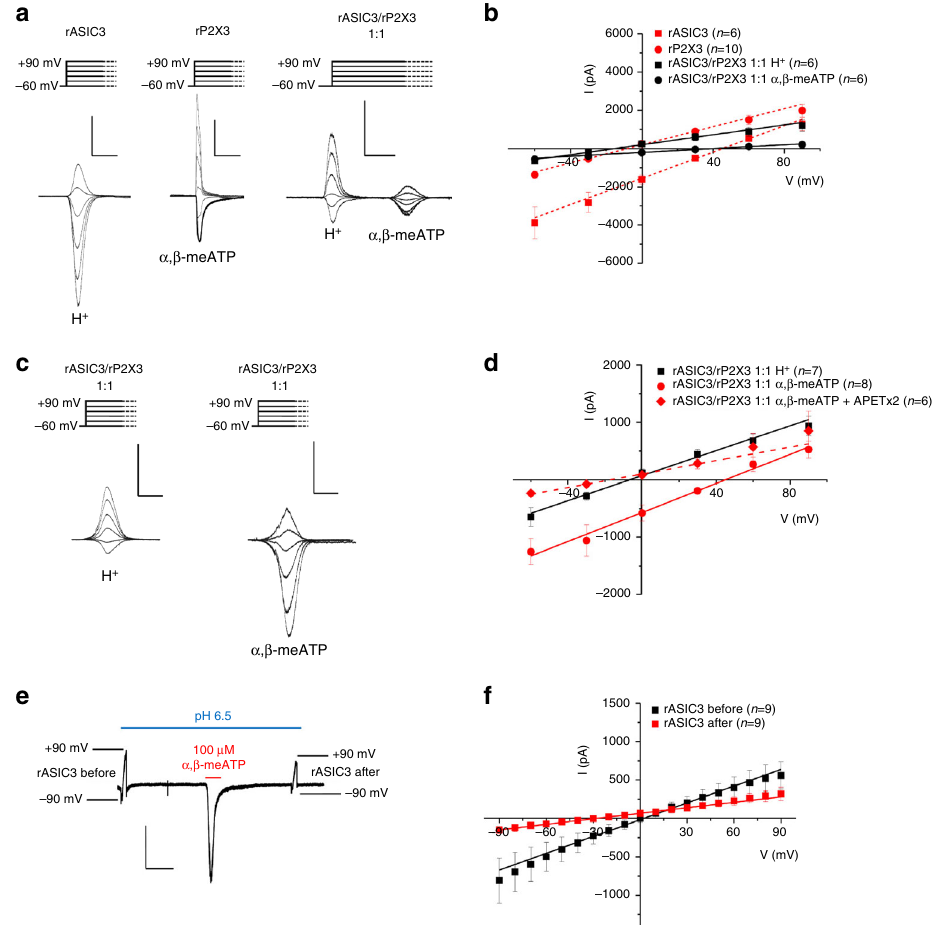
Fig. 5 Switch of reversal potentials between co-expressed rASIC3 and rP2X3Rs in CHO cells. Whole-cell patch-clamp recordings at a holding potential of − 65mV. a Current traces induced by protons (pH 6.5) and α , β -meATP (10 µ M) applied individually onto CHO-rASIC3 (left panel) and CHO-rP2X3R cells (middle panel) or successively onto CHO-rASIC3/P2X3 cells (right panel). Agonist application was at holding potentials which increased stepwise from − 60 to + 90 mV in 30 mV increments. Current – voltage relationships were constructed from recordings similar to those shown in ( a ) in order to determine the reversal potentials ( E rev ) ( b ). Means± S.E.M. of the indicated number of experiments. c Measurement of E rev of protons (left panel) and of α , β -meATP (right panel) by a similar protocol as shown in ( a ) on separate populations of CHO-rASIC3/rP2X3R cells. Under these conditions, the E rev values of these two agonists were interchanged. Current – voltage relationships constructed from recordings similar to those shown in ( c ) in order to determine the E rev ( d ). Means± S.E.M. of the indicated number of experiments. Blockade of ASIC3 channel activity by the selective antagonist APETx2 (0.1 µ M) shifted the E rev of α , β -meATP back near to its original value of around 0 mV. e In CHO-rASIC3/rP2X3R cells, ramps of 200 mV duration ( − 90 to + 90 mV) were delivered at a holding potential of − 65mV to determine the E rev of ASIC3 after a drop of the normal pH from 7.4 to 6.5. Then, a high concentration of α , β -meATP (100 µ M) was applied in order to change the distribution of extra- and intracellular ions. Eventually, the E α , β -meATP. rev was re-determined after washing out Original tracing; large capacitive artifacts at the beginning and end of the ramp-induced currents were retouched. f Current – voltage curves were constructed from the indicated number of experiments similar to that shown in ( e ). The scale labels for the vertical bars were 2 nA ( a , left panel), 1 nA ( a , middle and right panels), 1 nA ( c ) and 500 pA ( e ). The scale labels for the horizontal bars were 1 s ( a , c ) and 2 s ( e